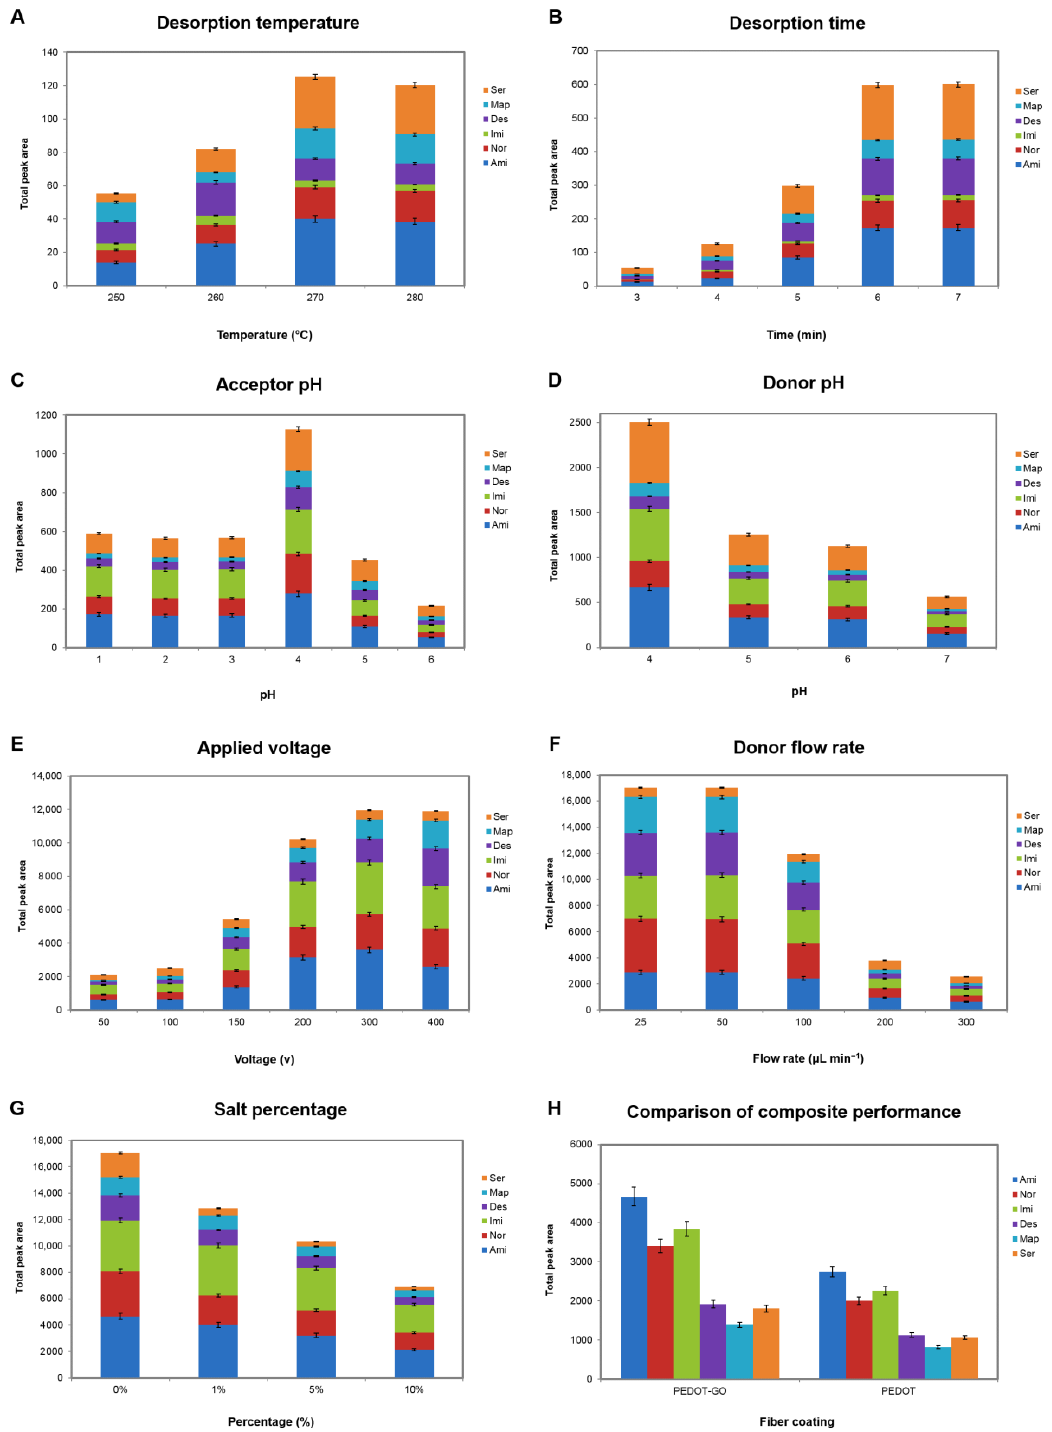
Figure 5. ( A – G ) Optimization of effective parameters on extraction procedure. Extraction conditions for the first optimization experiments (desorption temperature) include: desorption time: 4 min, acceptor pH: 1, donor pH: 6, voltage: 100 V, sample solution flow rate: 200 µ L min − 1 , and in the absence of salt; and ( H ) comparison of the capability of the PEDOT-GO and PEDOT fiber coating in the extraction of TCAs via proposed chip. Extraction was carried out under the optimized conditions: desorption temperature: 270 ◦ C, desorption time: 6 min, acceptor pH: 4, donor pH: 4, voltage: 300 V, sample solution flow rate: 50 µ L min − 1 , and in the absence of